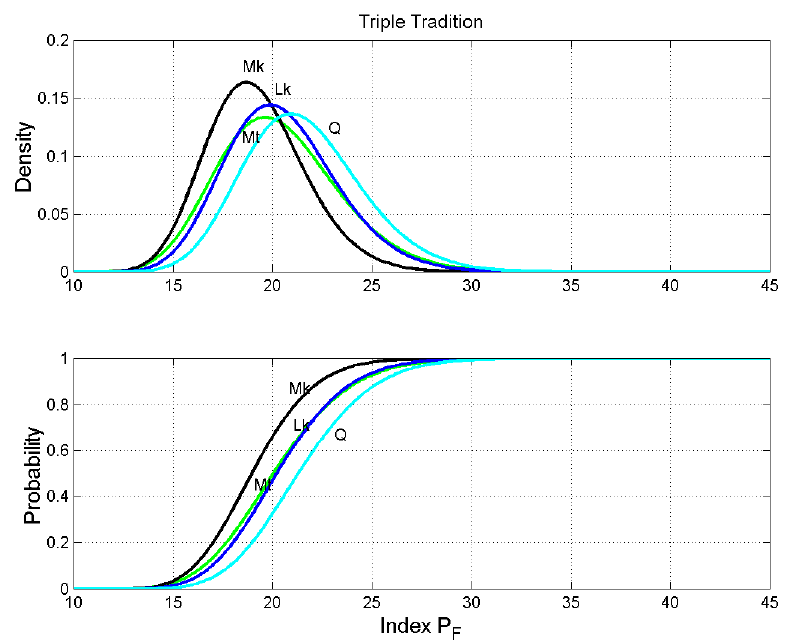
Figure 5. Triple Tradition. Probability density functions (upper panel) and probability distribution functions (lower panel) of the number of words per sentence P F . Matthew : green line; Mark: black line; Luke : blue line; Q : cyan line.